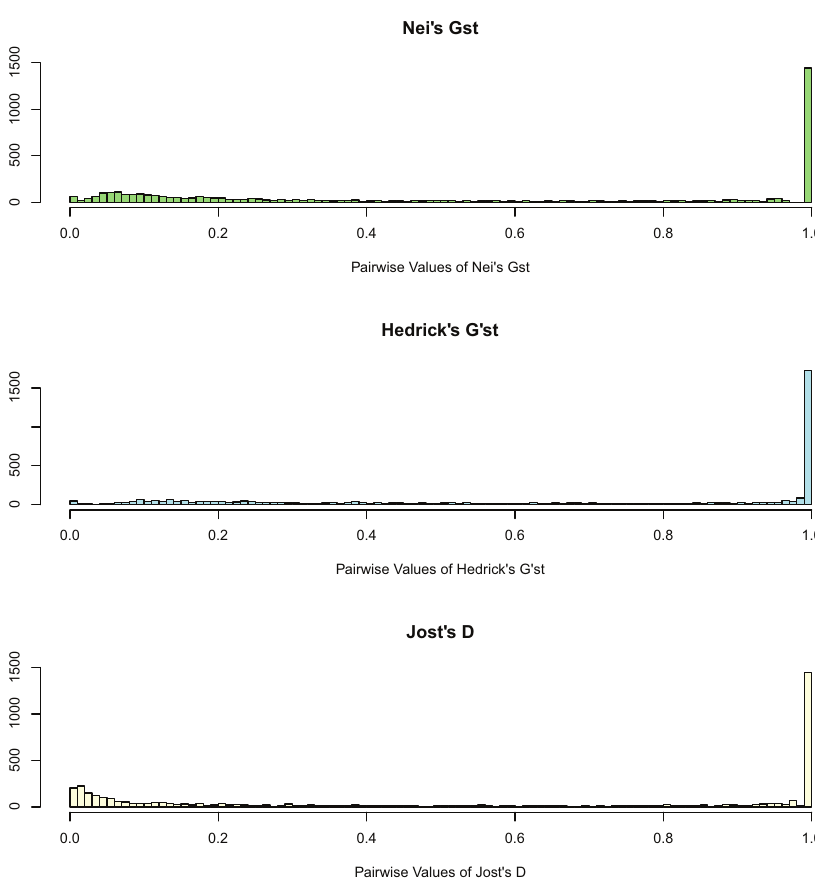
Figure 2. Pairwise Gst, G’st and D distribution. Pairwise values of Nei’s Gst (green), Hedrick’s G’st (blue) and Jost’s D (yellow) are plotted by their